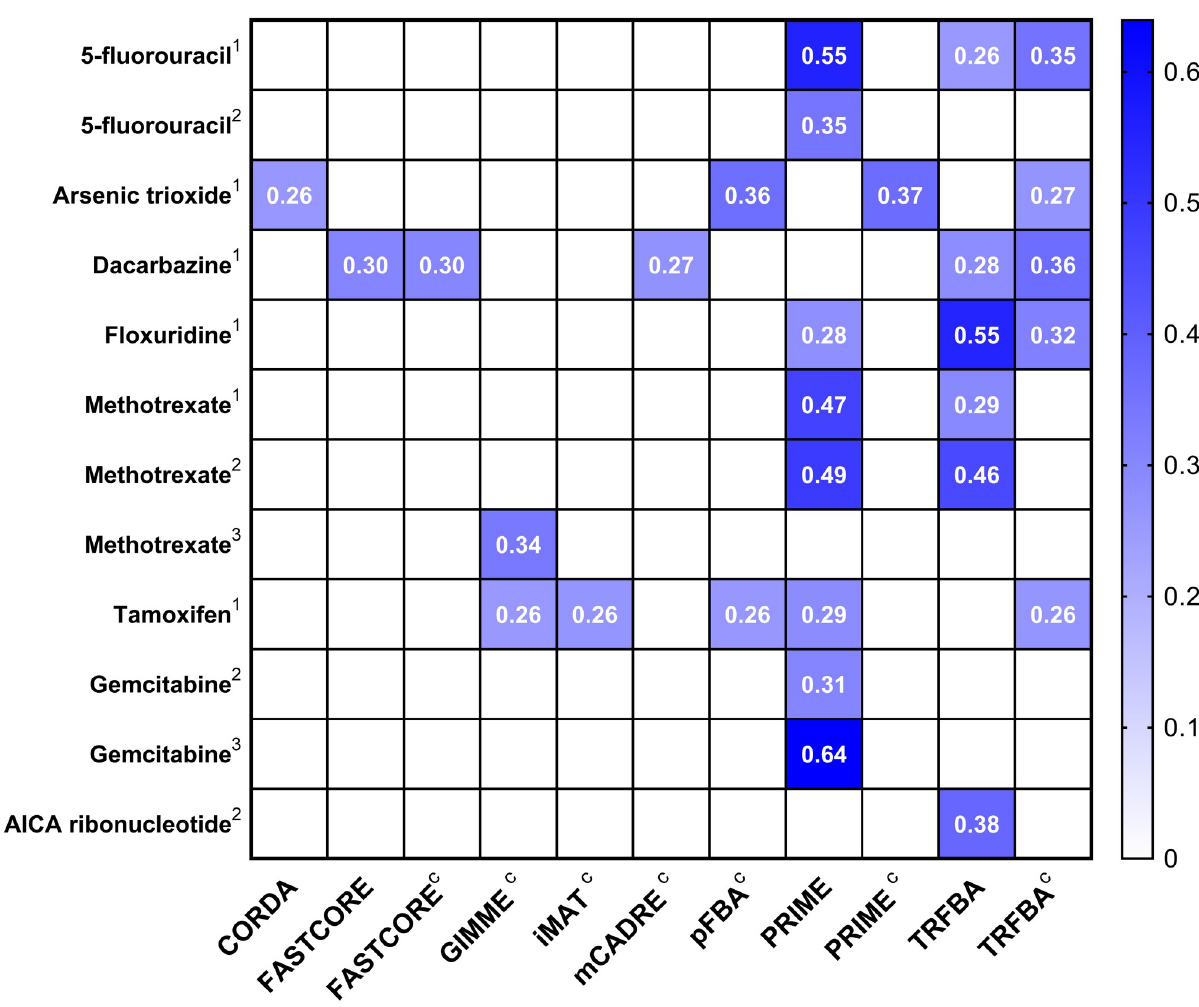
Fig 3. Drug response predictions. Heatmap of significant Spearman correlations between simulated and experimental drug response data. The Spearman coefficients for each drug have been shown on the figure. Superscripts indicate drug response data taken from (1) Holbeck et al [38], (2) Garnett et al [39] and (3) Yang et al [40]. Only methods with significant drug responses are shown.